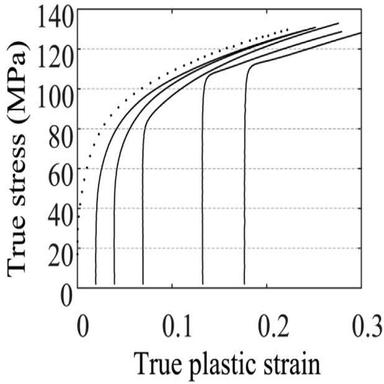
True stress-strain curves in tension along the RD after rolling in the TD to various strain levels and corresponding monotonic stress-strain curve. The true plastic prestrain by rolling is estimated by the von Mises strain. All curves are plotted up to necking.